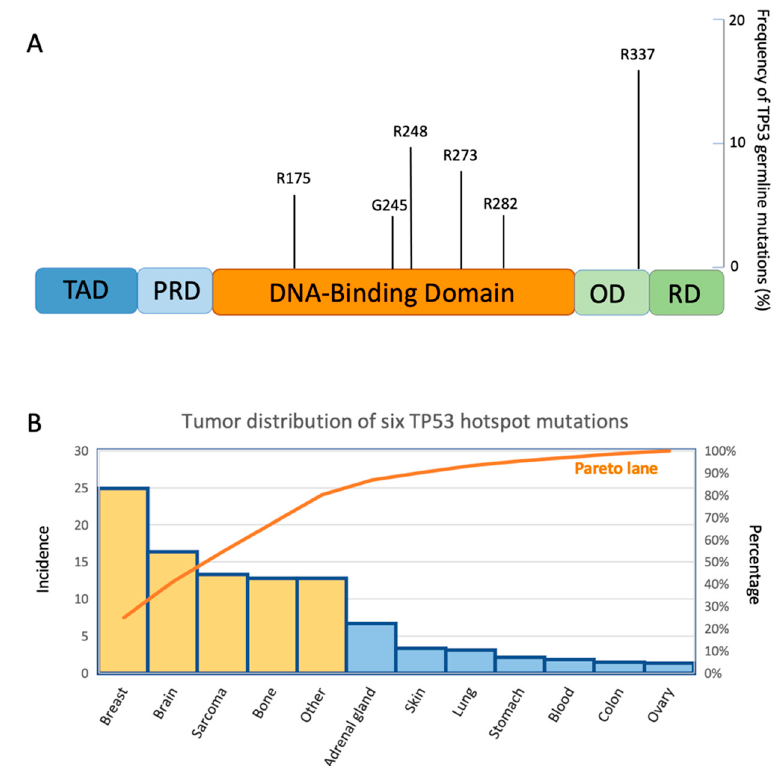
Figure 3. ( A ) A lolliplot showing six mutant p53 germline variants in Li–Fraumeni syndrome with their frequency of mutation. ( B ) Pareto diagram representing the frequency of occurrence of six mutant p53 hotspots in the LFS cancers. The orange bars represent the tumors with a higher percentage of TP53 mutations according to the Pareto analysis.